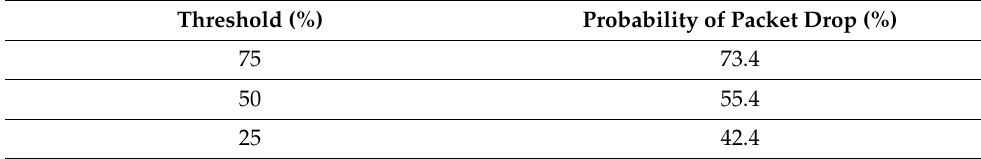
Table 1. The probability of packet loss rate under different